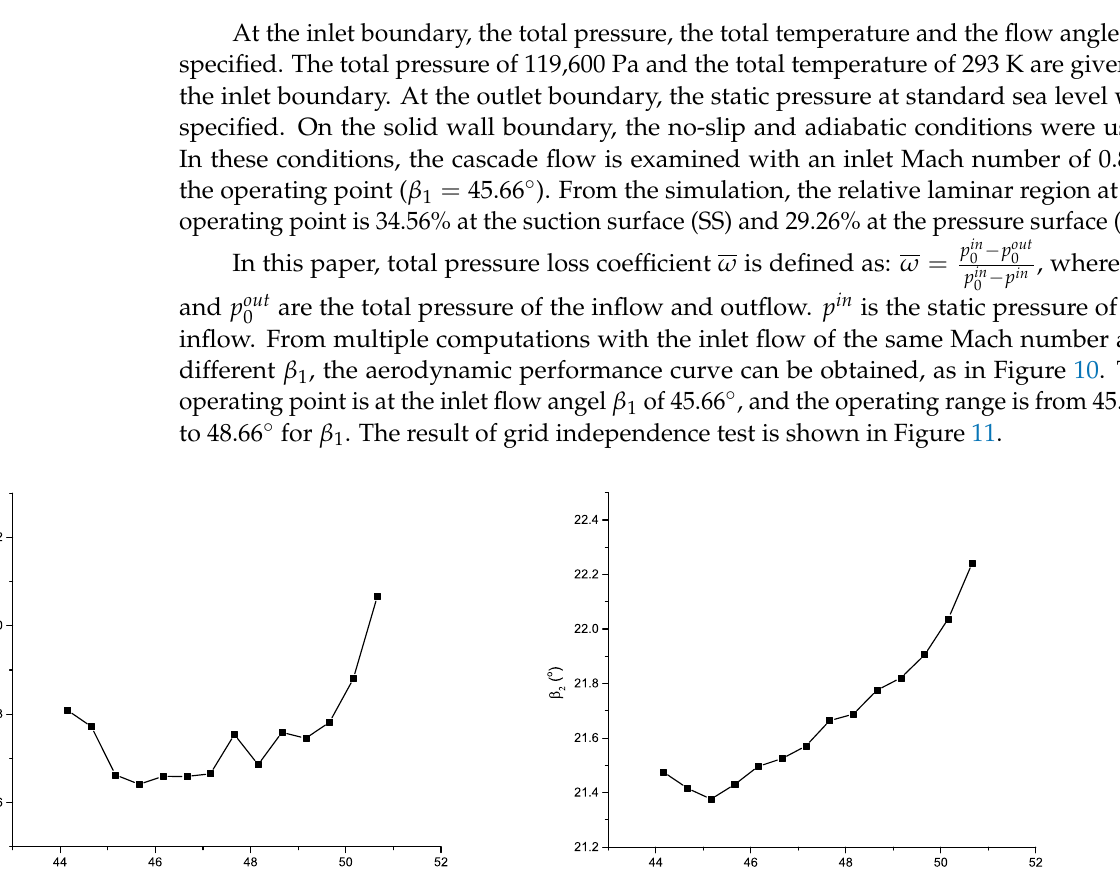
Figure 9. An illustration of computational grid of the cascade.